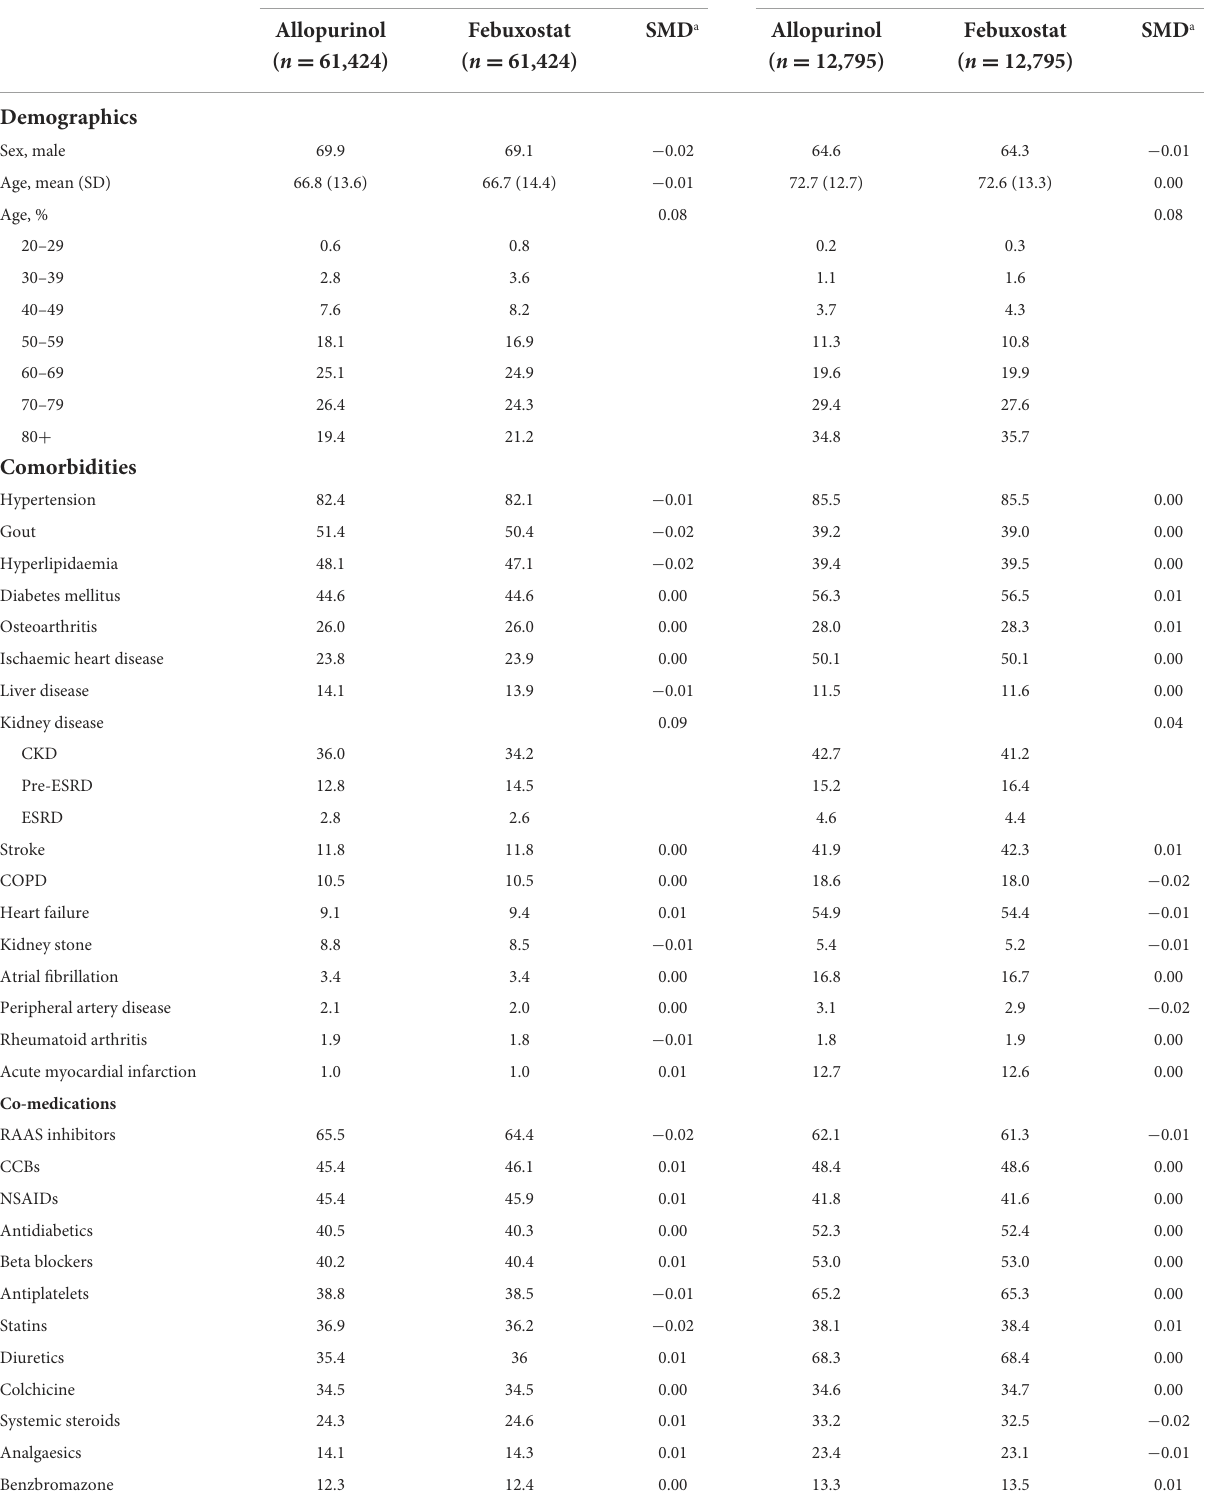
TABLE 1 Baseline characteristics of the study